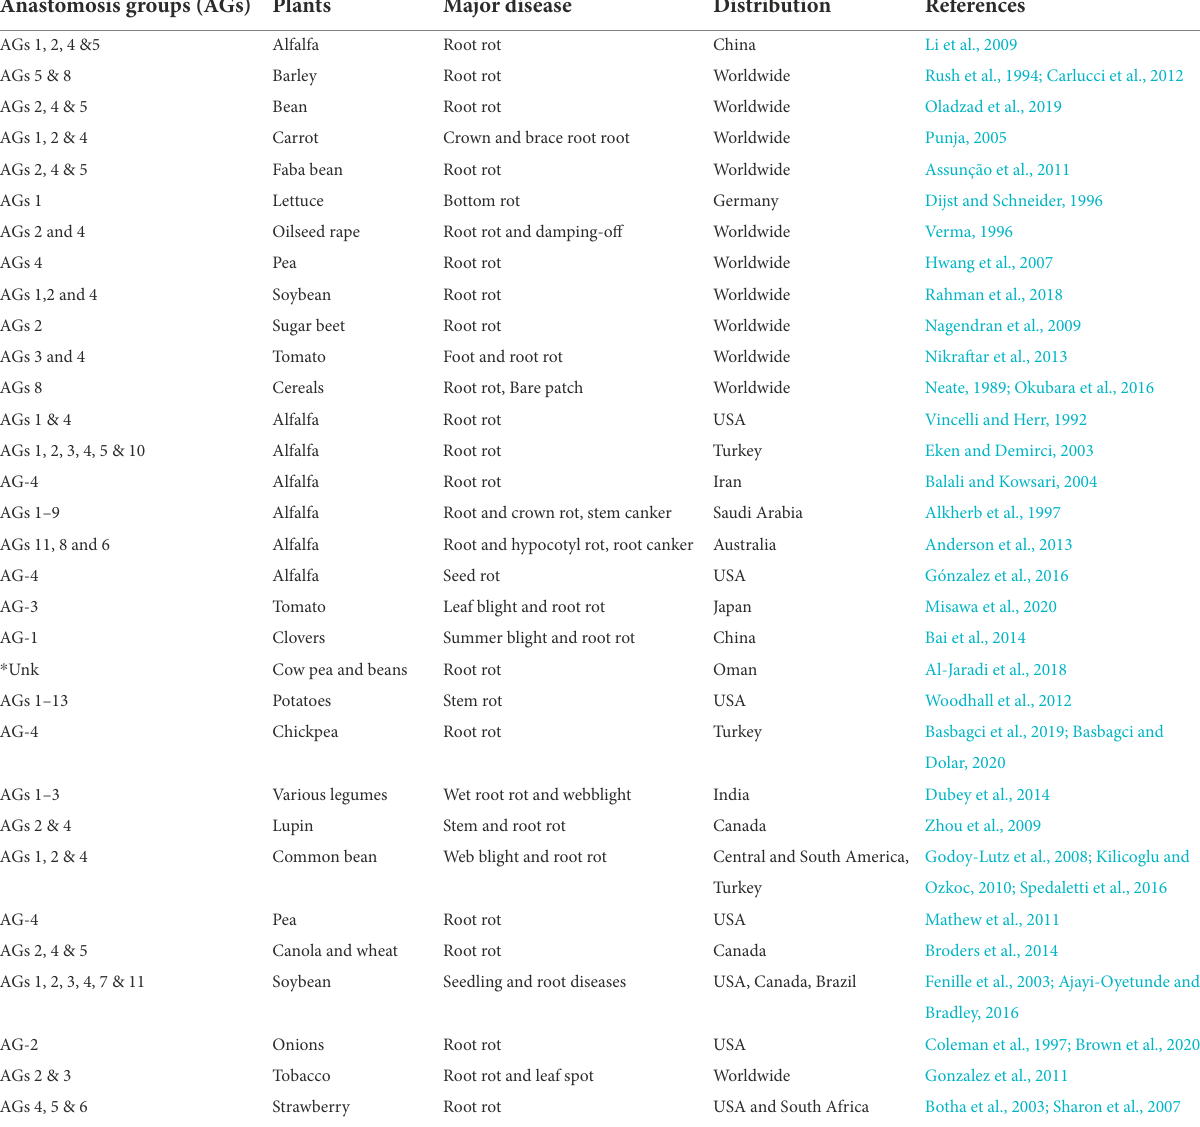
TABLE 4 Economically important plants including alfalfa affected by anastomosis groups (AGs) of Rhizoctonia solani root rots. Anastomosis groups (AGs)